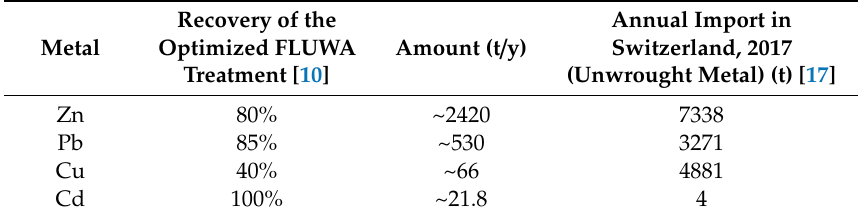
Table 4. Total amount of Zn, Pb, Cu, and Cd that is recoverable by the FLUWA process. The data of the raw import in Switzerland in 2017 only refers to the unwrought metal (no. 7901, 7801, 7403, and 8104 of the Swiss Explanatory notes of the Customs Tari ff —Tares